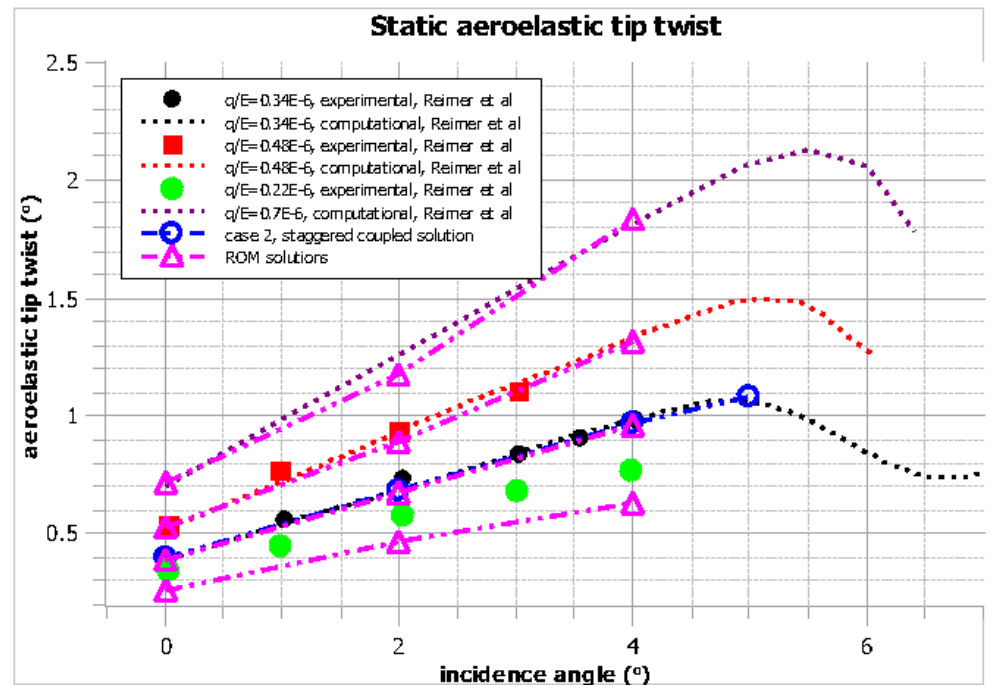
Figure 17. Case 2: static aeroelastic twist angle at several incidence angles and dynamic pressure values.